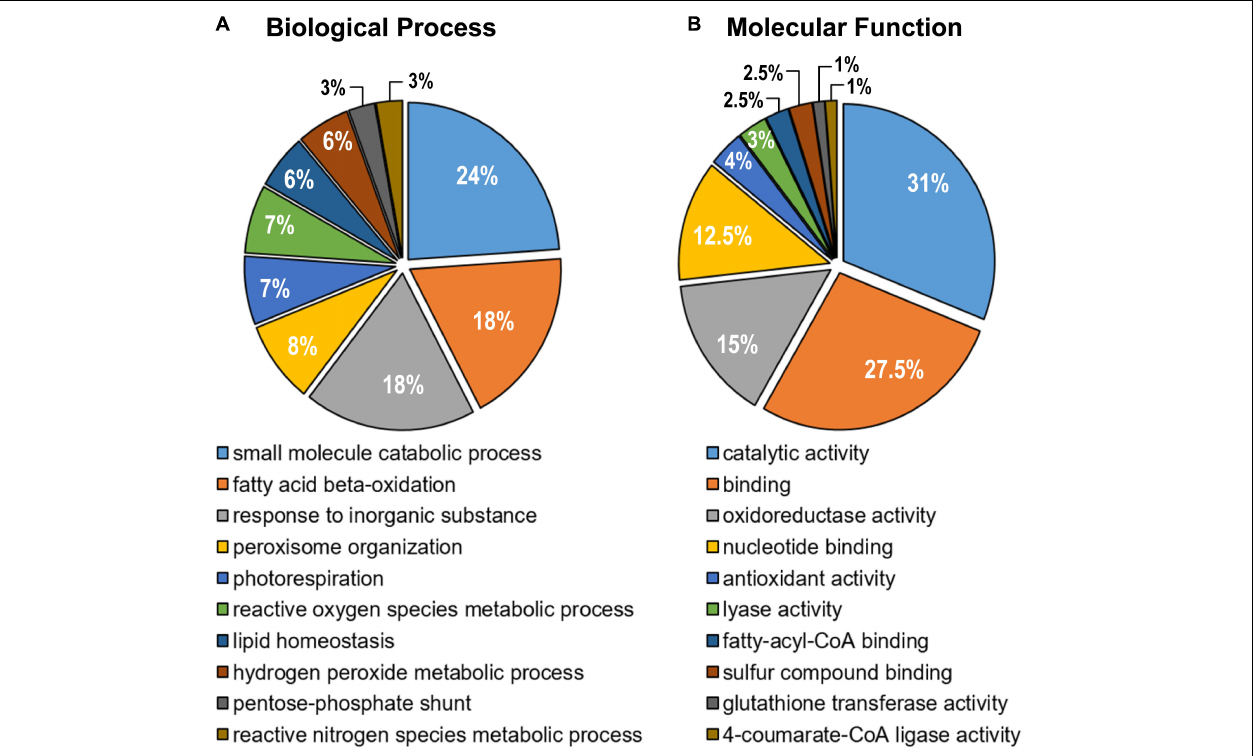
FIGURE 3 | Gene Ontology enrichment analysis of the identified peroxisomal proteins from sweet pepper ( Capsicum annuum , L.) fruit. (A) Biological process. (B) Molecular function. After GO term enrichment analysis, the different categories with their corresponding p -values were filtered using the REViGO tool to remove redundant GO terms. The number of proteins assigned to each functional category is expressed as a percentage